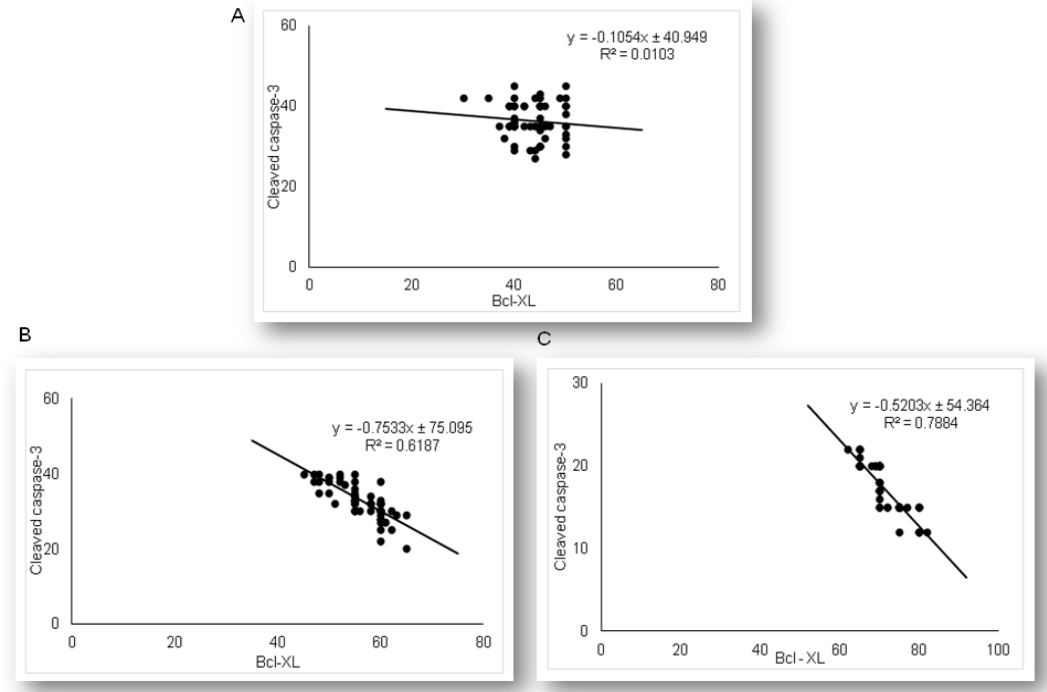
Figure 6. The correlations are shown for Bcl-XL and cleaved-caspase-3 in the renal tubular epithelial cells: ( A ) LPS group only, ( B ) simvastatin 20 mg / kg group, ( C ) simvastatin 40 mg / kg group.